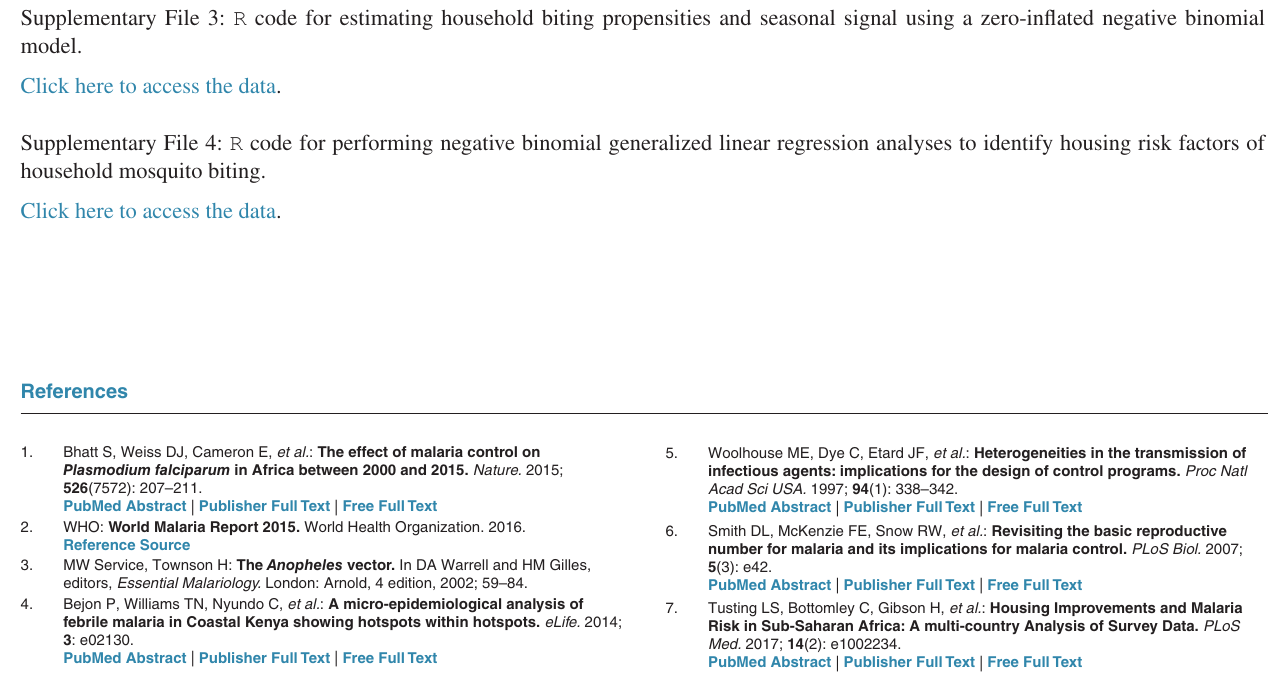
Figshare Dataset 1: The Ugandan mosquito count data, household-level housing covariates, environmental covari- ates, and a full list of enumerated households for the three study sites. https://doi.org/10.6084/m9.figshare.6797408.v3 53 . Data are available under the terms of the Creative